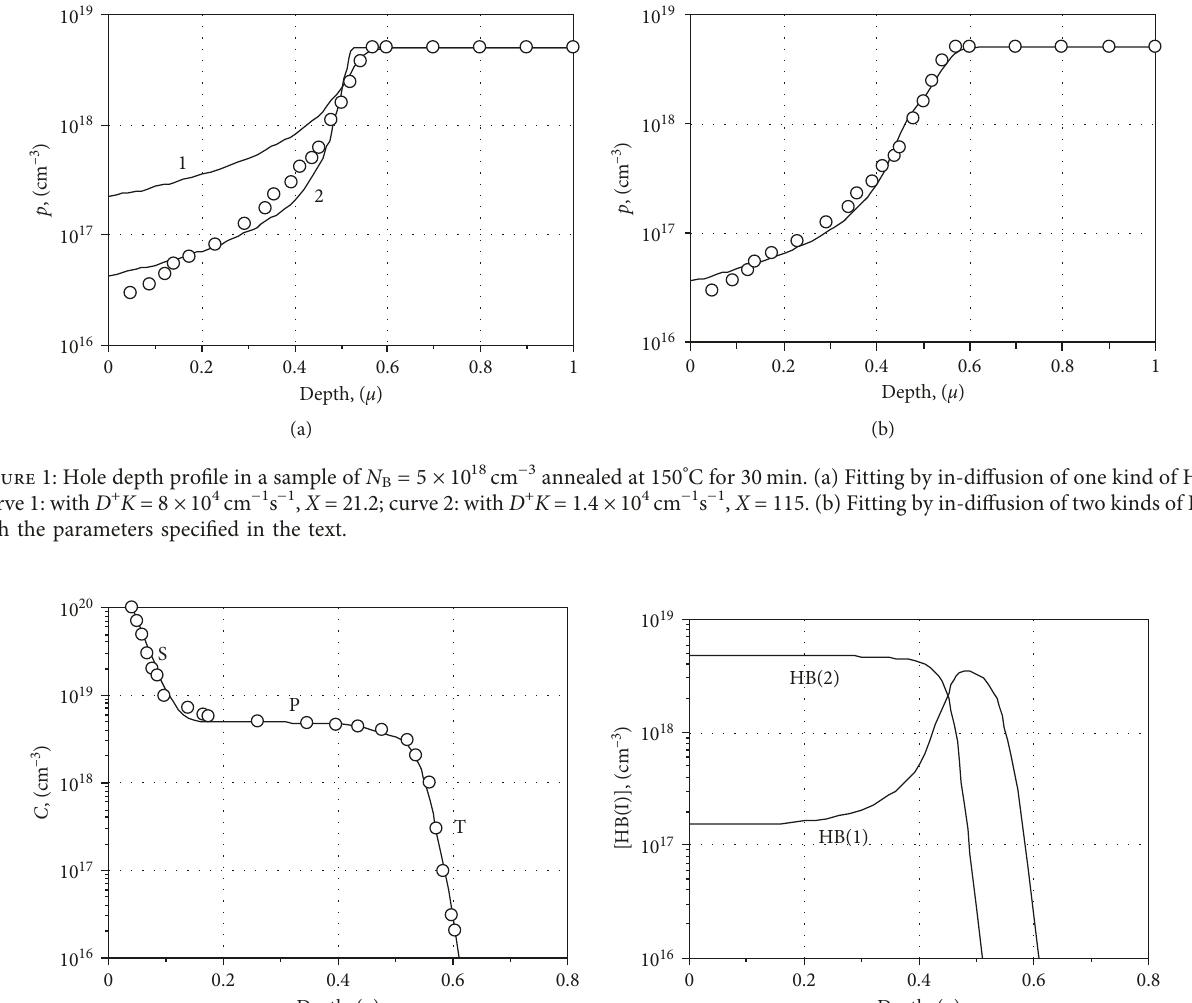
Figure 2: Concentration profiles for the sample of Figure 1. (a) Solid curve is computed for the same parameters that were used in Figure 1(b), and the experimental points (circles) are rescaled to match the experimental penetration depth by Figure 1. (b) Individual components of the passivated